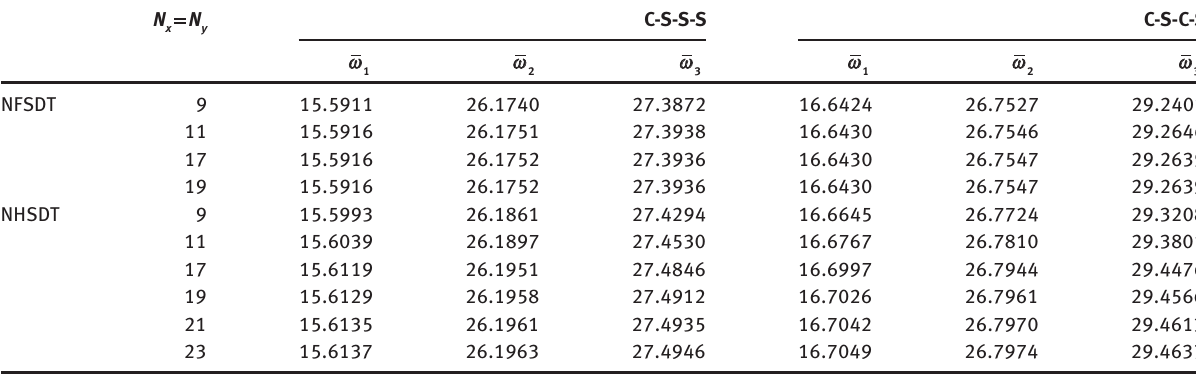
ω of FG plates on elastic foundation i